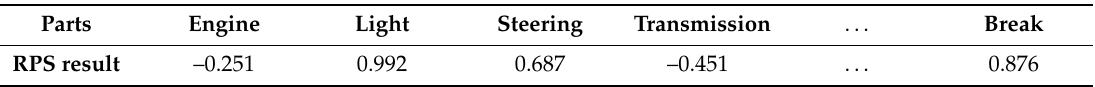
Figure 12. Algorithm 2 represents the process by which the NNVS learns neural networks. Table 3. The results that the random-forest part-diagnosis sub-module (RPS) delivered to the neural network vehicle-diagnosis sub-module